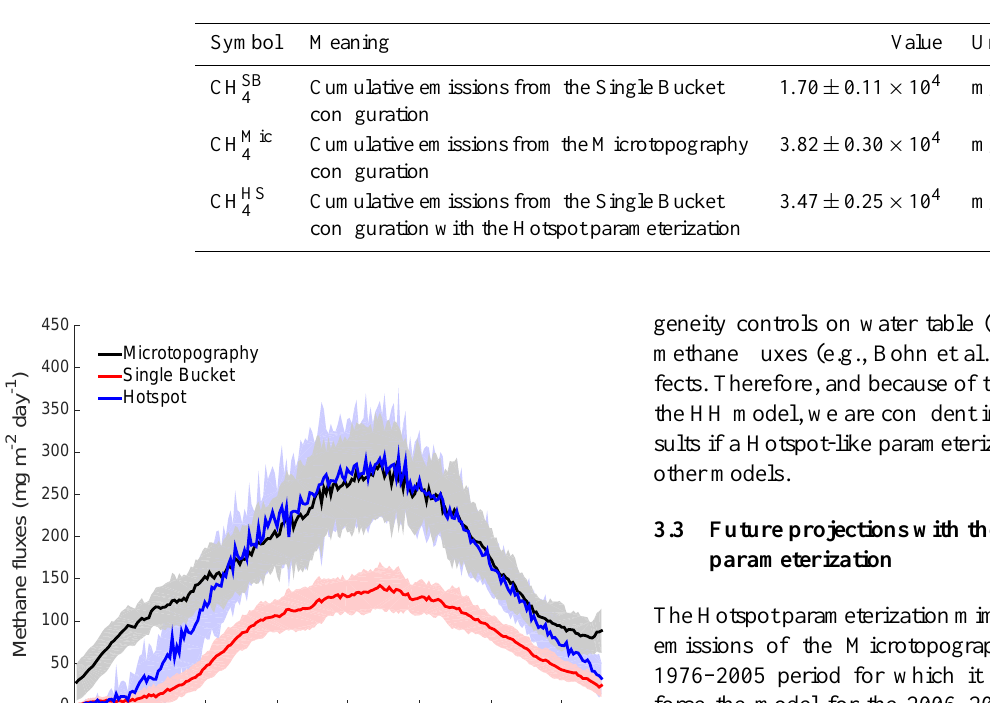
Table 3. Cumulative emissions from different model configurations. The Single Bucket configuration produces less than the half of the cumulative methane emissions with respect to the model with micro-topography representation. By inserting a simple parameterization of the saturated surface dynamics, we improve significantly the seasonal methane emissions.